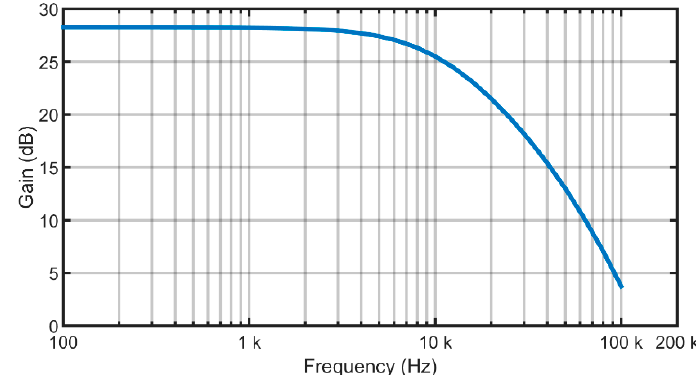
Figure 7. Simulated circuit frequency response.